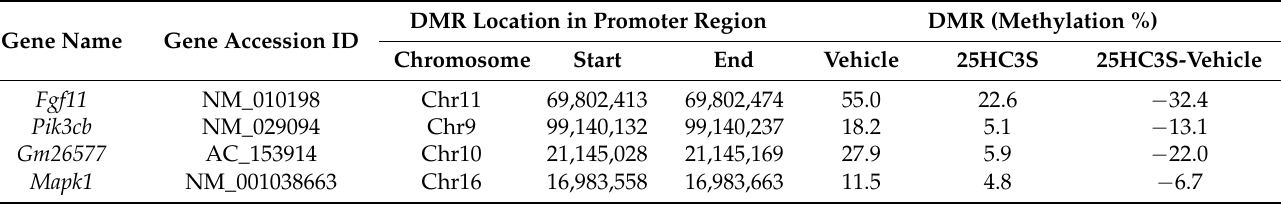
Table 1. Methylation of DMR in gene promoter regions of PI3K-AKt signaling